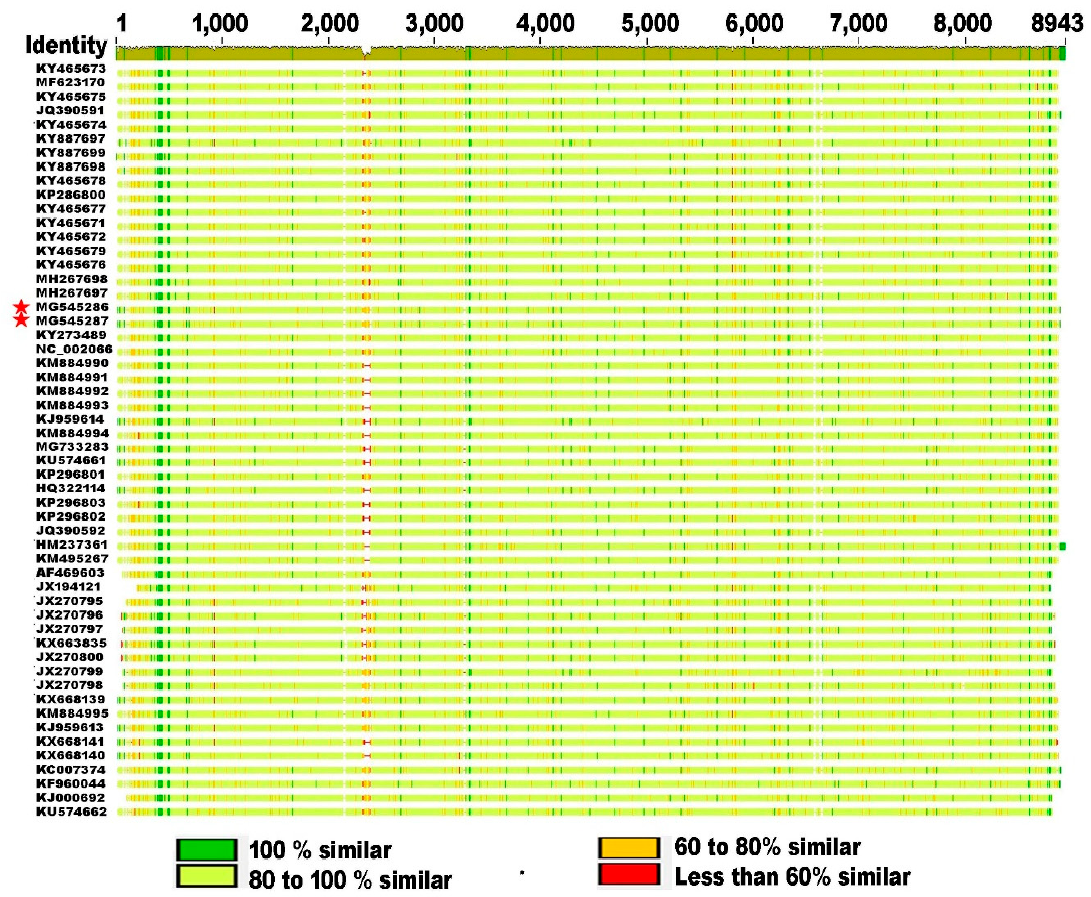
Figure 2. Alignment of SBV genomes. The 52 SBV genomes that are available from the NCBI Viral Genomes Resource [PMID: 25428358], including the RefSeq genome of SBV NC_002066.1, were aligned using MUSCLE. The columns are numbered by the alignment coordinates, and the identity graph in the top panel is colored by conservation, with height indicating coverage. The polyprotein spans from approximately position 200 to 8,800. The U.S.A. isolates described in this manuscript are highlighted by red stars. The color boxes at the bottom panel shows the individual aligned sequences with positions colored by the level of conservation.